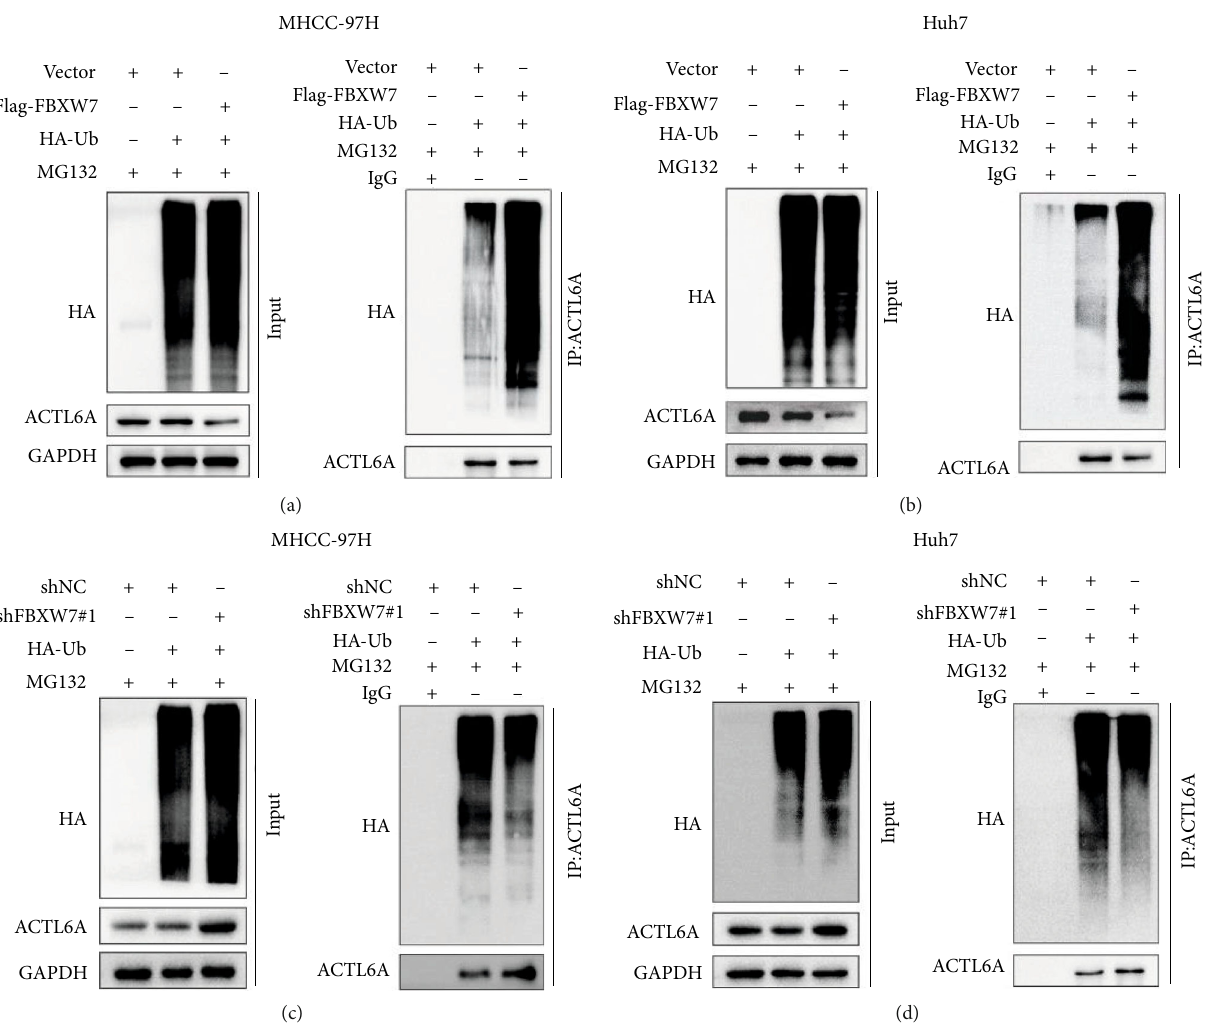
Figure 6: Ubiquitination of ACTL6A in MHCC-97H and Huh7 cells was regulated by FBXW7 overexpression or knockdown in the presence of MG132 (10 μ M, 12h) detected by IP and immunoblotting. (a, c) MHCC-97H cells. (b, d) Huh7